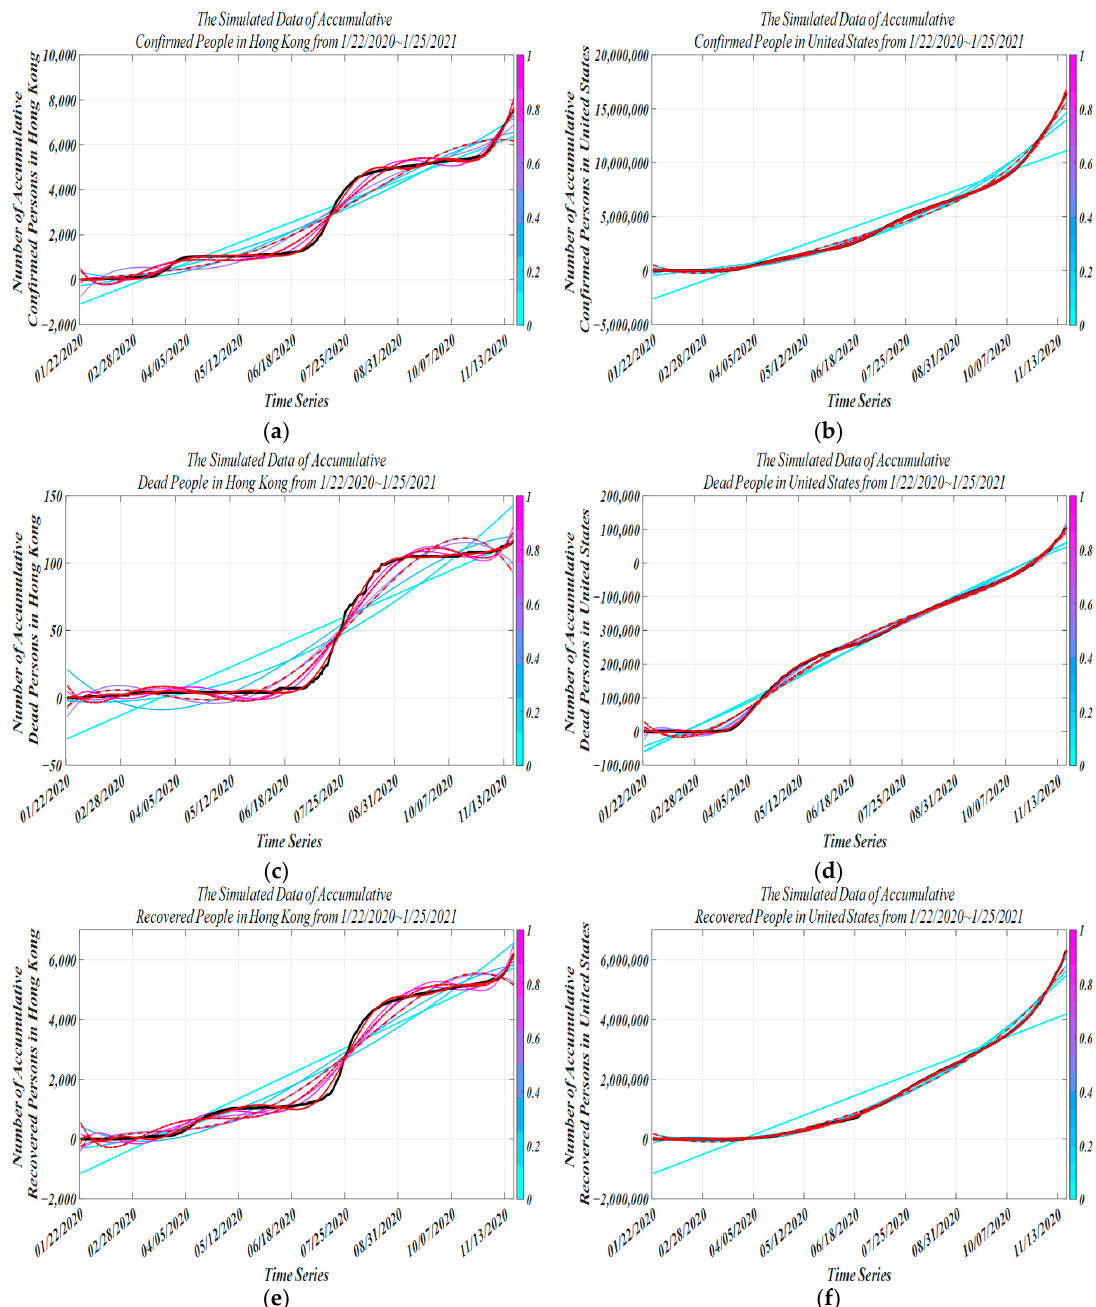
Figure 3. Simulated data vs. actual data from 22 January 2020 to 25 January 2021 (black curve, actual data of accumulative dead people; other curves, simulated data of accumulative dead people; different color curves, different degrees of fitness; red solid line, our methodology; red dashed line, SIRD-RM model; red dashed line with dots, SEIRDV model) ( a ) vs. ( b ) accumulative confirmed people ( c ) vs. ( d ) accumulative recovered people ( e ) vs. ( f ) accumulative dead people. In Table 5, according to the parameter estimation method, we obtained four param- eter values suitable for the model. Using the simulation experiment of the model, we ob- tained the value of the natural conversion rate.